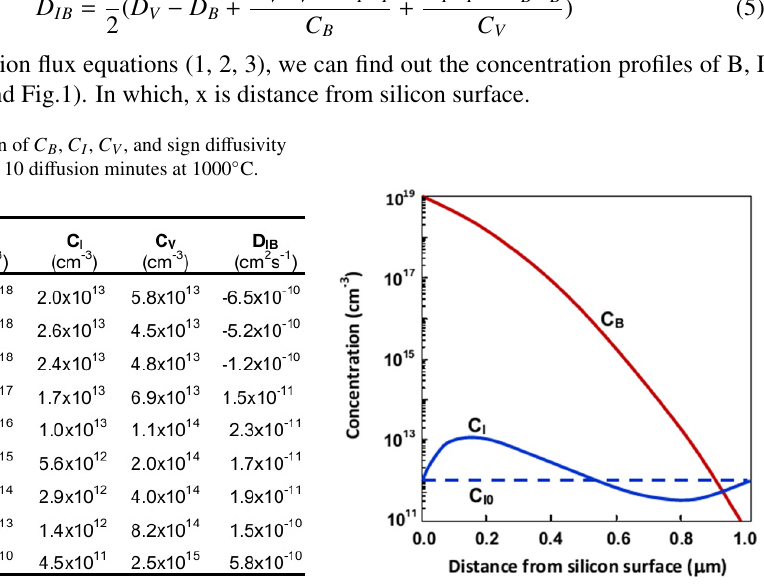
Figure 1. Concentration profile of B and I in